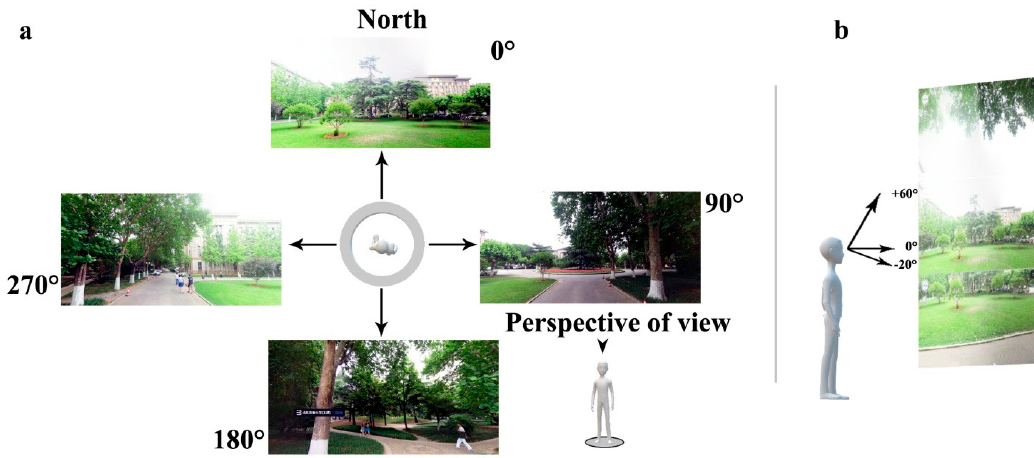
Figure 5. BSV images acquired in horizontal directions ( a ) and vertical view angles ( b ) at a street sample site.